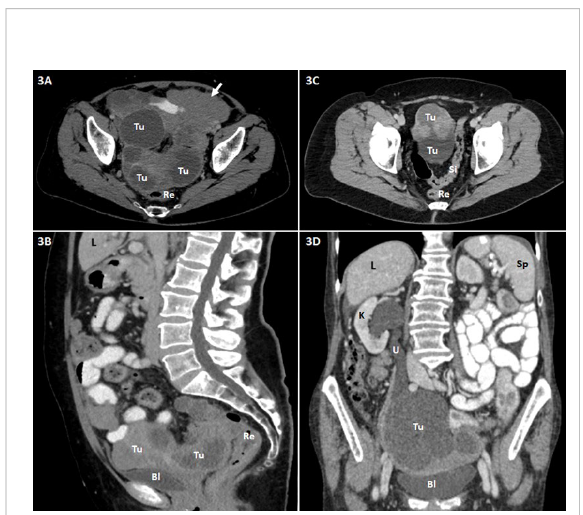
FIGURE 4 Representative axial intravenous contrast-enhanced CT scans of the middle abdomen. The absence of numerous small mesenteric lymph nodes is shown (A, B) ; only small vessels in the mesenteric root are visible. (C, D) Other patients show multiple small mesenteric lymph nodes (<1 cm in short dimension) in the mesentery and mesenteric root (arrows).